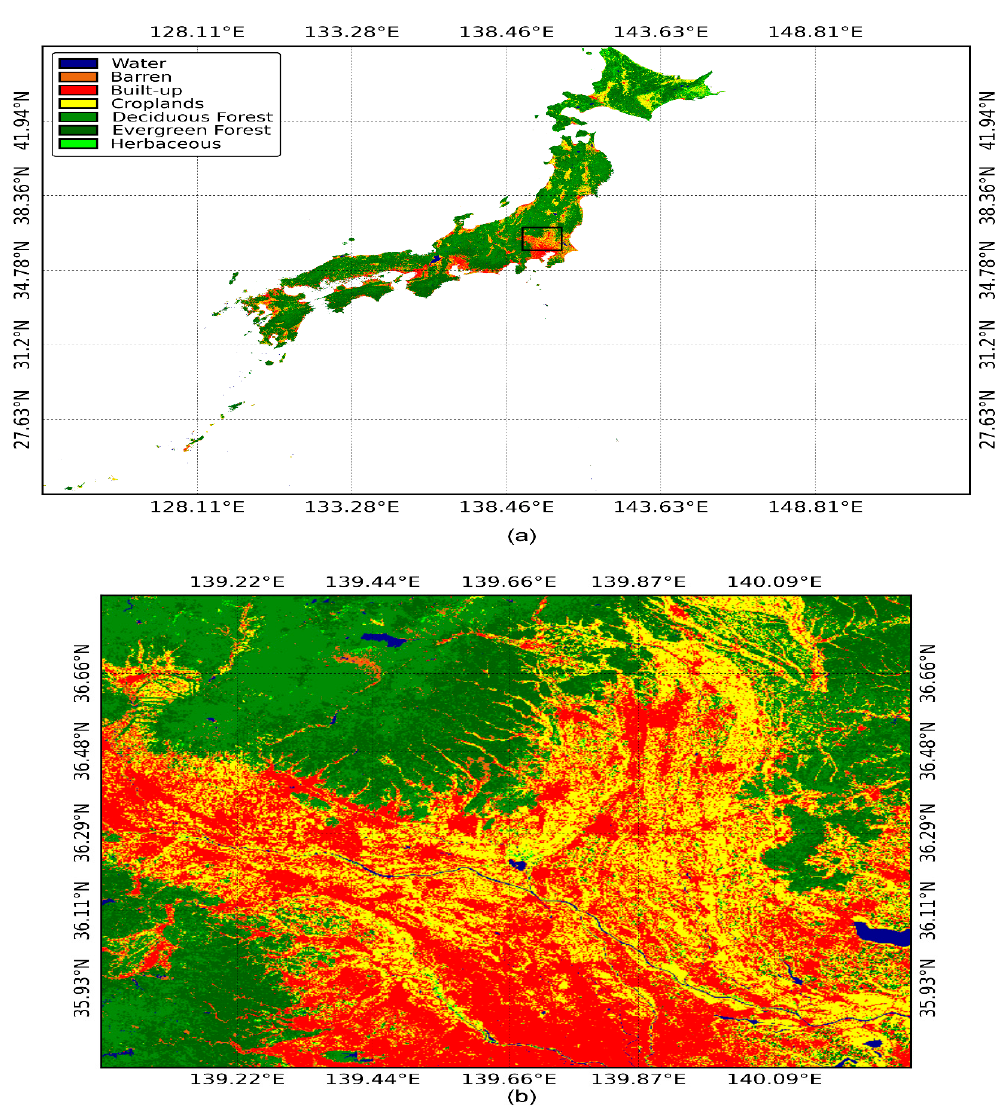
Figure 5. Japan 30-m land cover (JpLC-30) map of 2013–2015 produced through the research: ( a ) display of the national territory; ( b ) zoomed in over the black polygon region in ( a ). The national boundary is based on the Global Administrative Areas database (GADM) Version 2.8, November 2015.